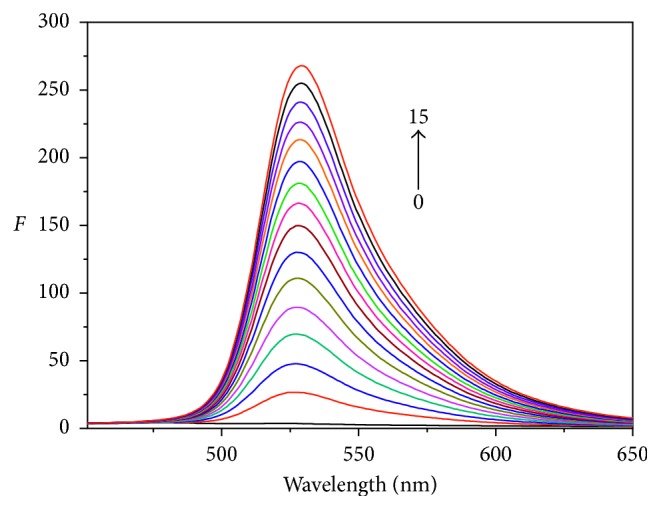
Emission spectra of hsDNA-Cu-bipy mixture in different concentrations of AO (pH = 7.40, λex = 411.7 nm). From curves 0–15, c(hsDNA-Cu-bipy) = 1.0 × 10−5 mol·L−1; c(Cu-bipy) = 0.00, 0.33, 0.67, 1.00, 1.33, 1.67, 2.00, 2.33, 2.67, 3.00, 3.33, 3.67, 4.00, 4.33, 4.67, and 5.00 × 10−6 mol·L−1, respectively.